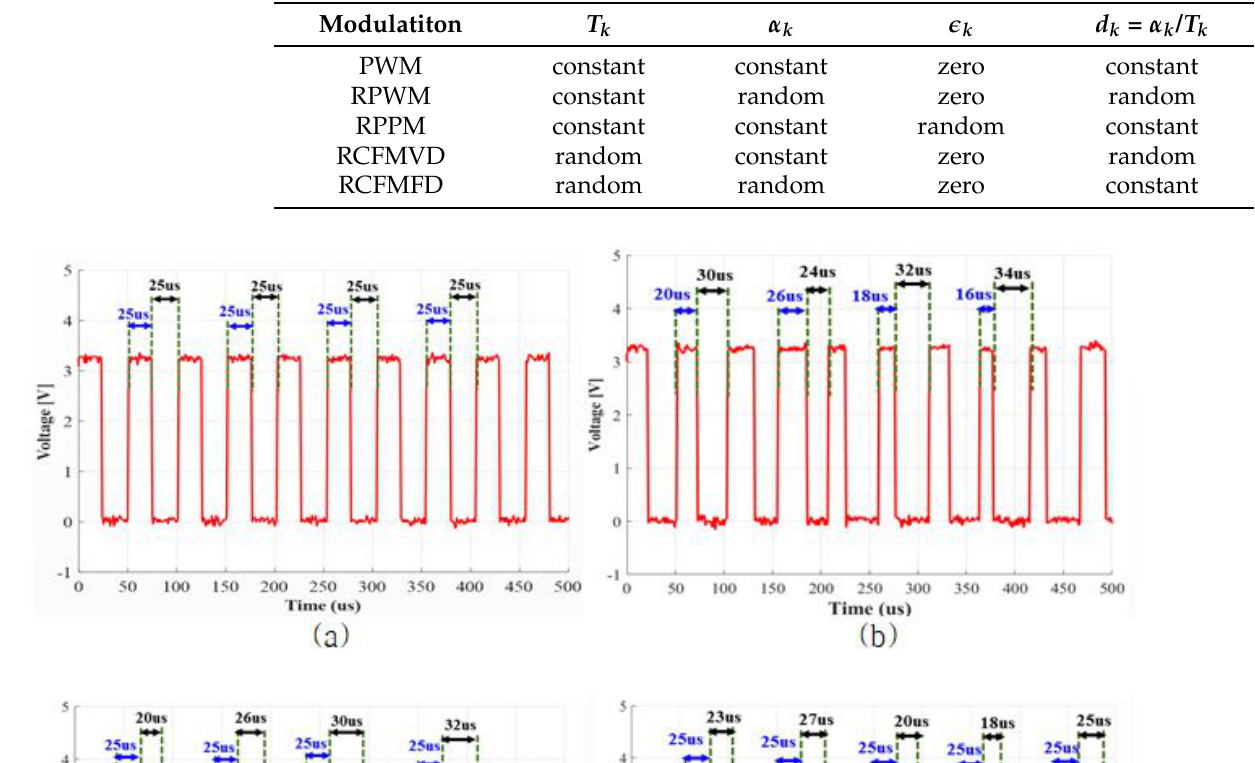
Table 1. Summary characteristics of different switching schemes [1].